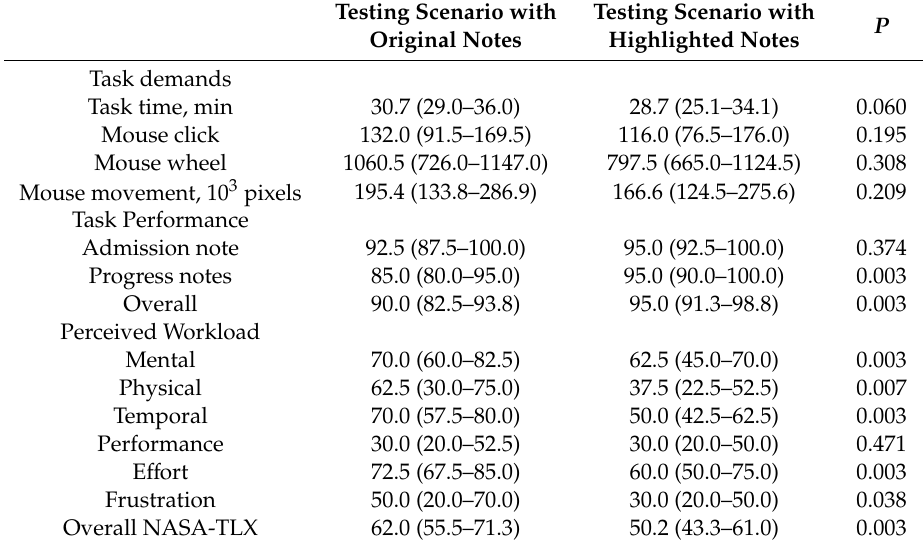
Table 3. Comparison of task demands, task performance, and perceived workload between scenarios using original notes and highlighted